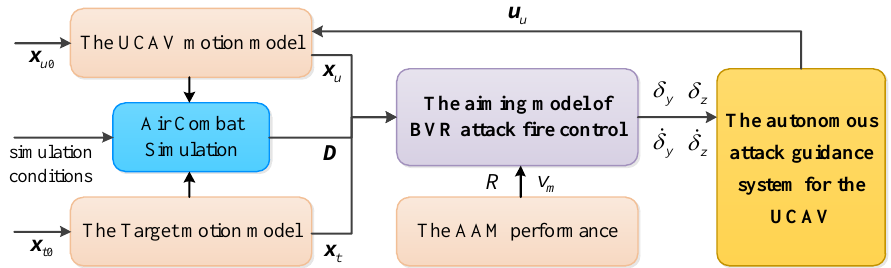
Figure 5. Architecture of the autonomous attack guidance